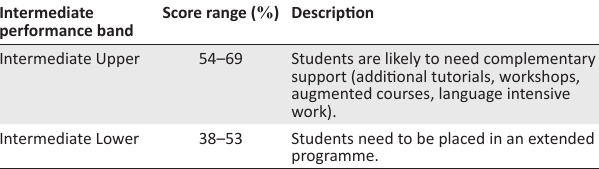
TABLE 4: National Benchmark Tests Project quantitative literacy test degree Intermediate benchmarks and how they should be interpreted. Intermediate Score range ( % ) performance band